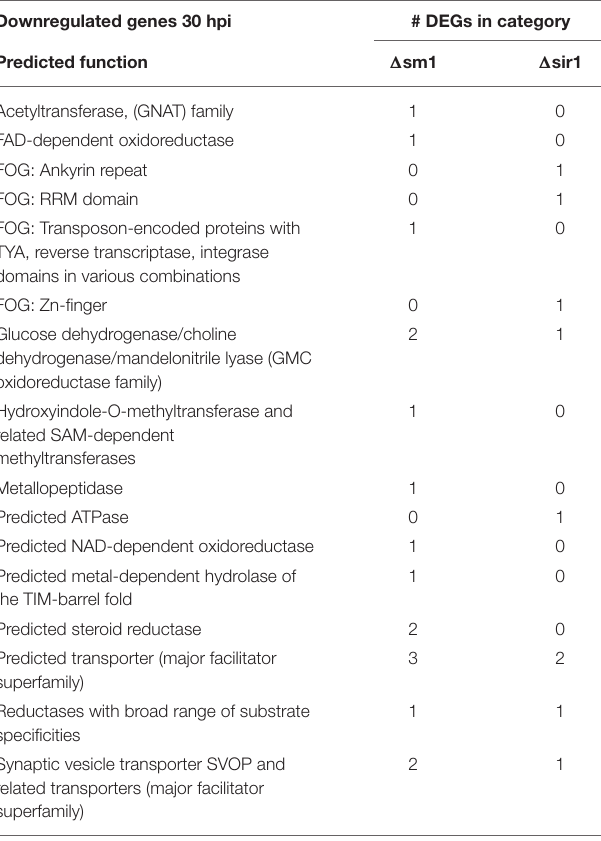
TABLE 5 | Upregulated genes with general function KOGG annotation in 1 sm1 or 1 sir1 at 30 hpi. Upregulated genes 30